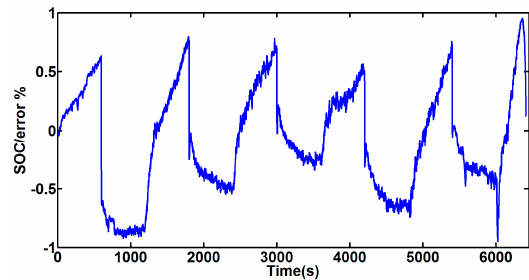
Figure 16. SOC estimation error.